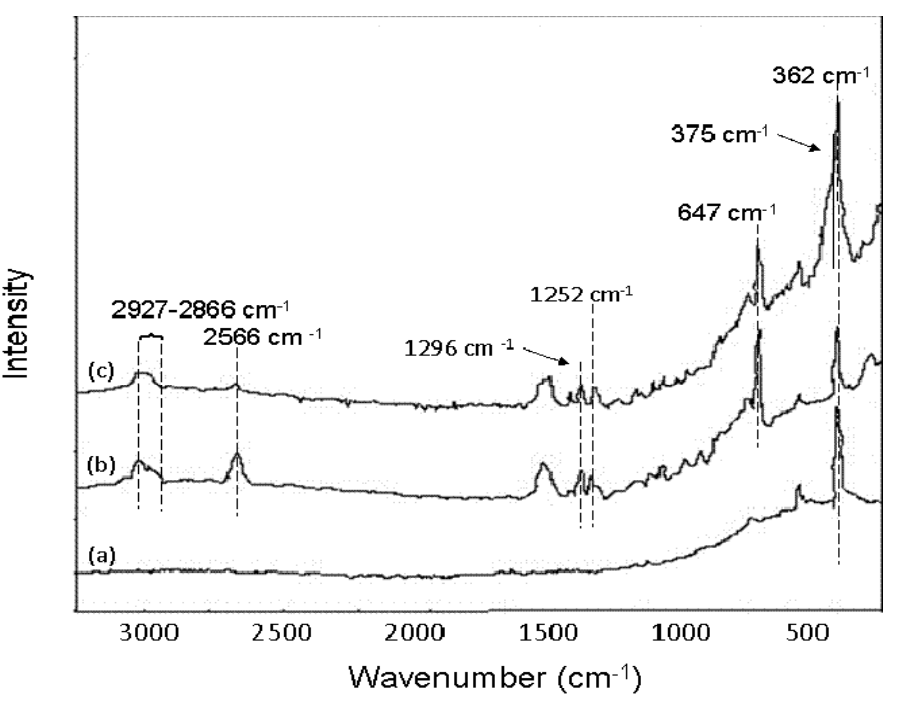
Figure 7. Raman spectra of ( a ) AA, ( b ) hybrid AA before and ( c ) after As(III) adsorption (after